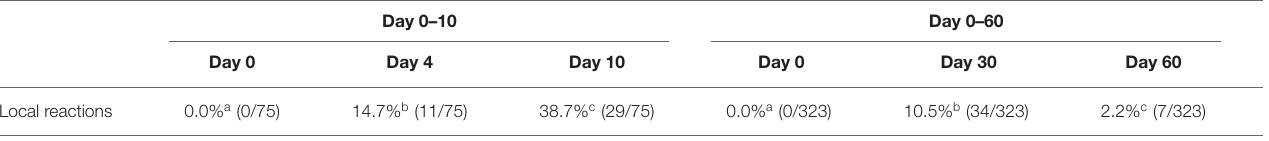
TABLE 4 | Percentage of cows with local adverse reactions defined as the increase in size of the area at the injection site within 4 days after the vaccination (Day 0) against foot-and-mouth disease administered in the neck region by subcutaneous